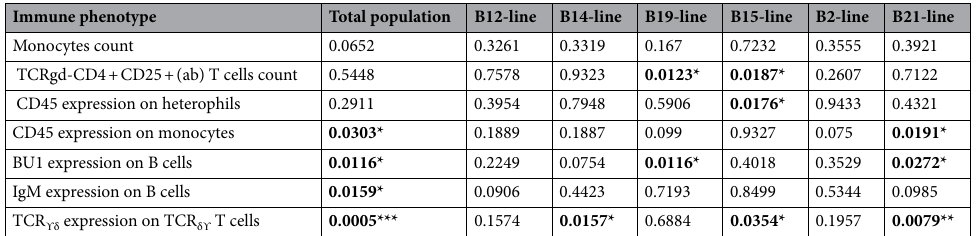
Table 3. Association between the caecal microbiota and immune phenotype in laying hens one week after their infection with IBV. Analysis of β-diversity on caecal microbiota by Adonis test. Associations between the microbiota and the concomitant immune phenotype are described through the p-value of Adonis test based on Bray–Curtis distance matrix and each immune parameter level. The associations are described in the total population, and in each line separately. When significant, the p-value of the effect is highlighted in bold characters (*p < 0.05, ** < 0.01, *** ≤ 0.001). Supplementary Table S9 provides the complementary results of Adonis model performed on all parameters followed from the immune phenotype, and that did not display significance.